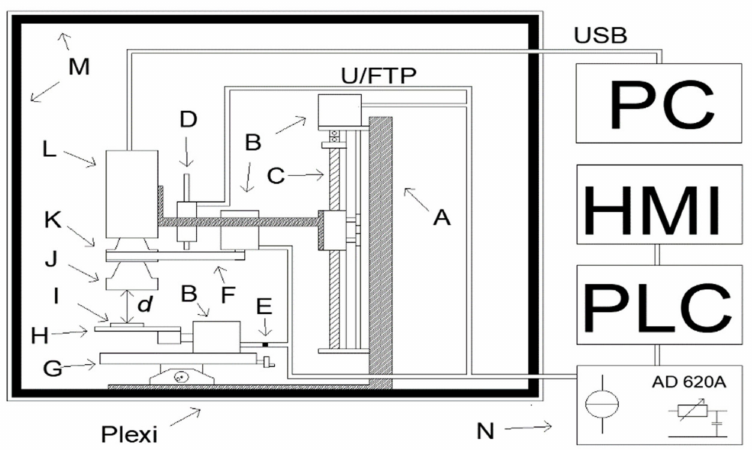
Figure 2. Schematic view of the measurement system: (A) tripod; (B) stepper motors; (C) linear guide; (D) resistance linear distance sensor; (E) connector; (F) rubber belt; (G) cross table; (H) additional table with adjustable angle position relative to thermal camera lens; (I) observed object; (J) additional macro lens: Close up lens 2x P/NT 197200; (K) thermal imaging camera lens; (L) thermal imaging camera; (M) polyurethane foam; (N) additional module with sources of current, filter systems and measurement amplifier; (d) WD (work distance)—distance between the observed object and thermal imaging camera macro lens = 33